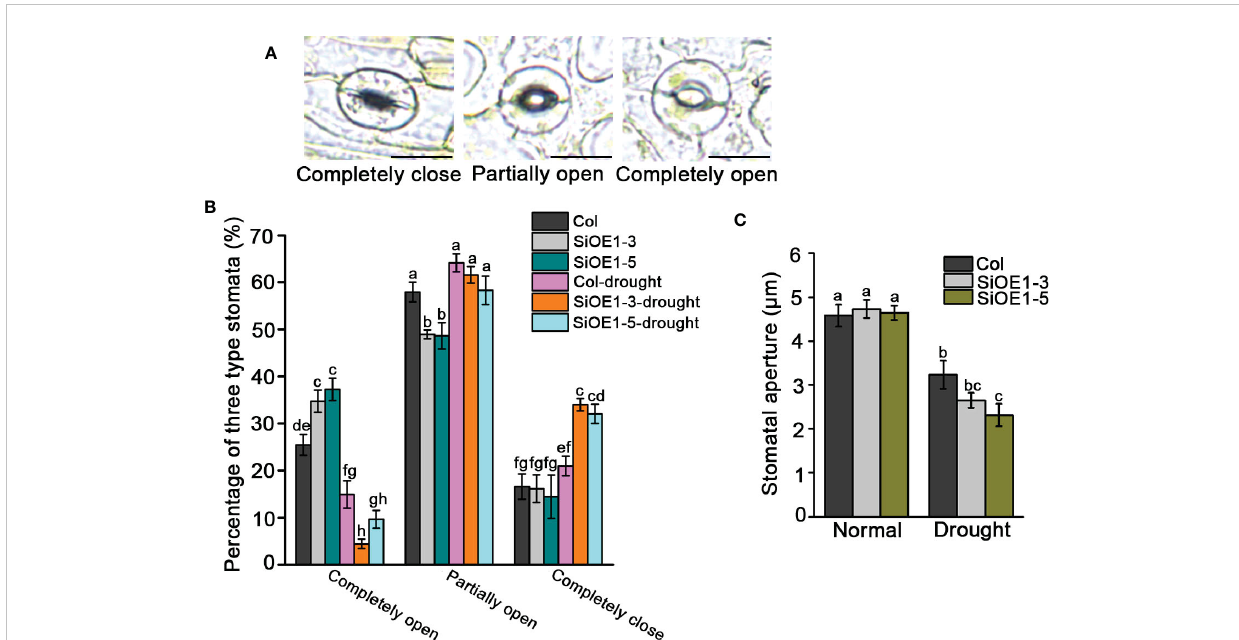
FIGURE 5 Stomata closure of SiNCED1 -overexpressing plants under drought stress. (A) Images of three levels of stomatal apertures, Bars = 10 m m. (B) The percentage of three levels of stomatal apertures in SiNCED1 -overexpressing plants and Col were calculated under normal and drought stress condition. (C) Comparison of stomatal apertures in SiNCED1 -overexpressing plant and Col under normal and drought stress condition. Data shown are mean ± SD from there independent replicate. Each experiment includes at least 30 stomata from each epidermal peel. Different letters represent